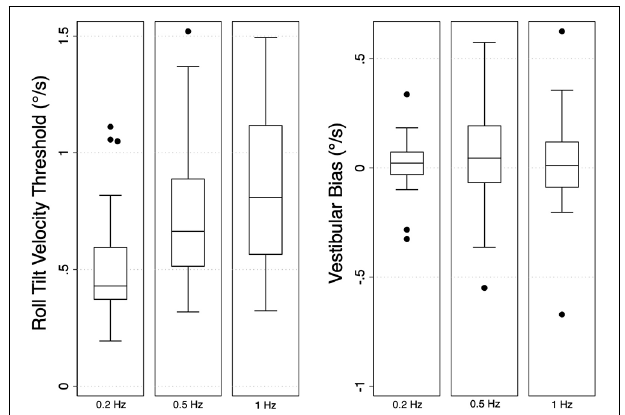
FIGURE 2 | Box plots showing the median values and distributions of vestibular thresholds (left) and biases (right) for each frequency of head-centered roll tilt ( N = 33). Velocity thresholds were found to increase with increasing frequency, while bias was similar at each frequency. Error bars represent ± 1.5 times the first (Q1; 25th percentile) and third (Q3; 75th percentile) quartiles [interquartile range (IQR) = Q3 − Q1]. Outliers, defined as points greater than 1.5x the IQR, are shown as filled black